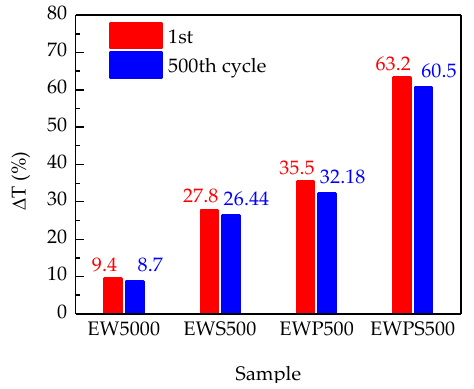
Figure 11. The transmittance modulation ability (∆ T at 628 nm) with ±2 V voltages at the 1st and 500th cycle. The ∆ T of these crystalline WO 3 films changed within 5%. Table 2. Comparisons with the past reported data: Electrochromic film, synthetic method, crystallinity, and ∆ T at 628 nm.